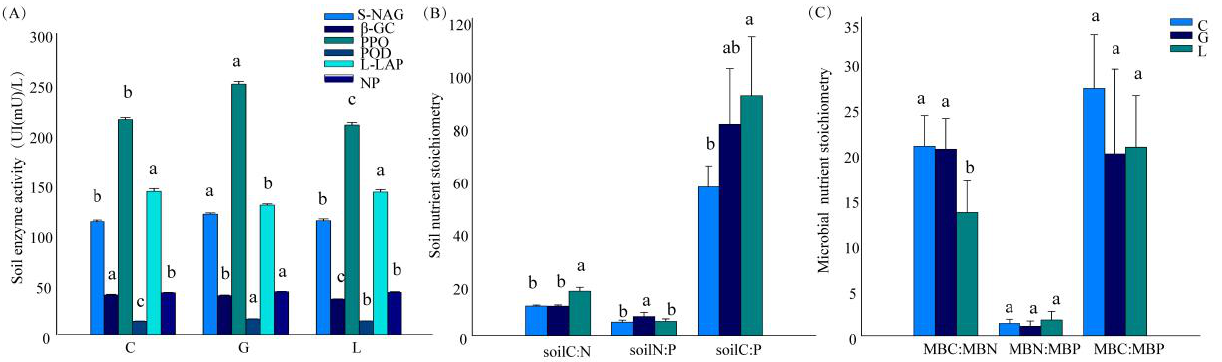
Figure 1. Stoichiometric characteristics of soil enzyme activities ( A ), soil nutrients ( B ) and micro- bial biomass ( C ) under three planting cover types. Different lowercase letters indicate significant differences according to Duncan’s test ( p <